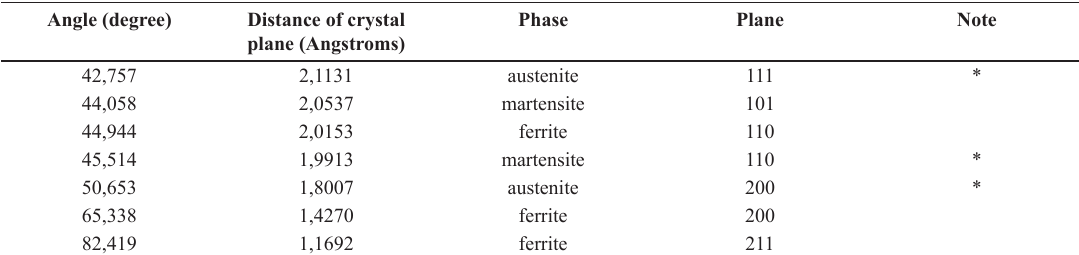
Table 8: Phases identified by X-ray diffraction in the CGHAZ region of two wires SAW joint (T-SAW). Angle (degree) Distance of crystal plane